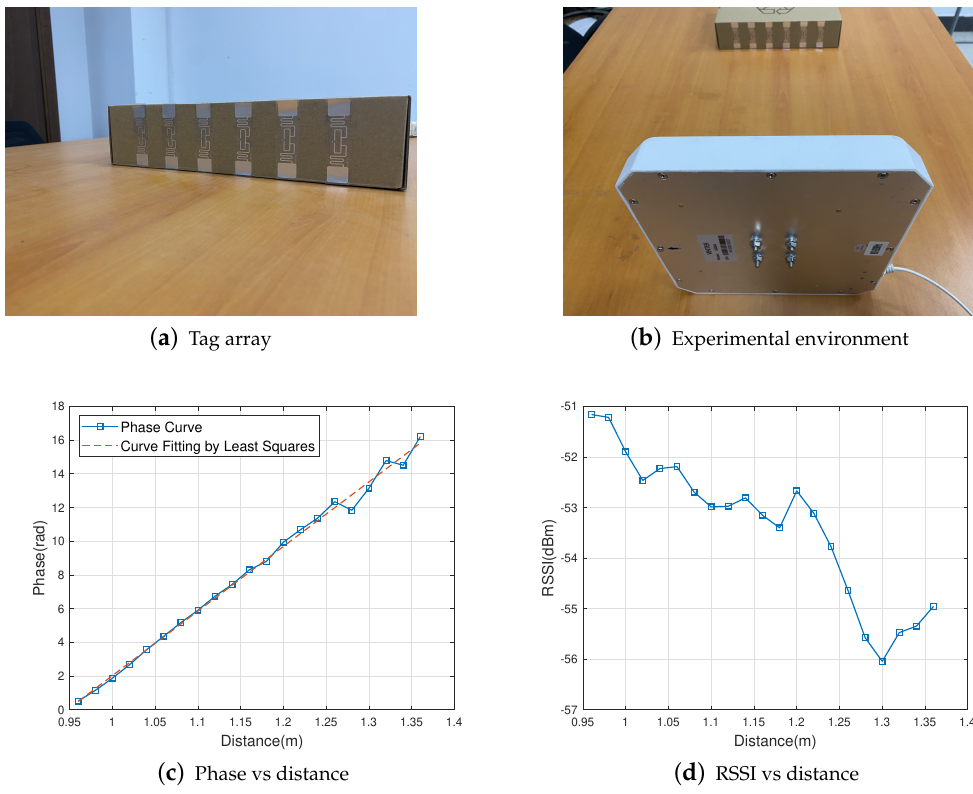
Figure 2. Robustness comparison of phasing and RSSI.